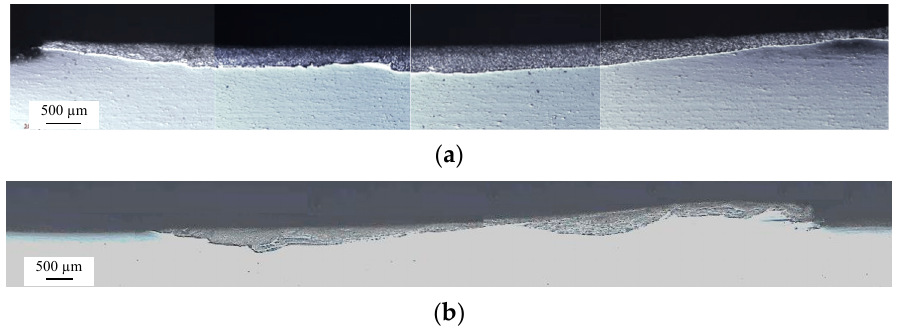
Figure 6. Panoramic image of the cross-section of the processed samples showing the composite surface using: ( a ) a tool with a hole size of 6 mm and a plunge depth of 0.6 mm; and ( b ) a tool with a hole size of 6 mm and a plunge depth of 0.9 mm.